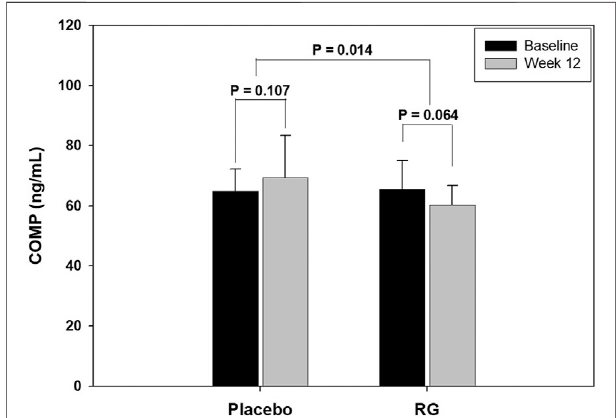
Comparison of supplementation effects between two groups by two-sample t -test.